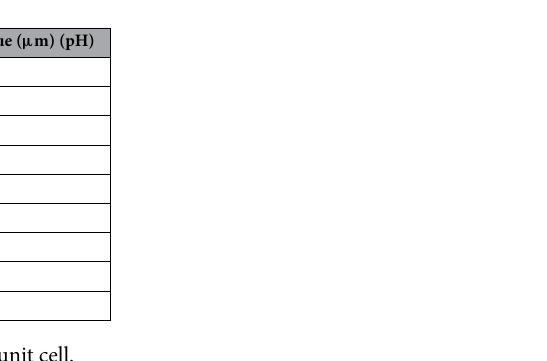
Figure 1. ( a ) Schematic depicting the terahertz transmission through the proposed MM configurations. The incident THz field is polarized parallel to the split gap i.e, along the y axis. ( b ) Magnified view of the unit cell of the MM comprising of a toroidal SRR and two asymmetric C shaped resonators made up of aluminium. The two C shaped resonators are placed symmetrically on both sides of the TSRR. The dimensions of the unit cell are periodicity ‘ P x ’ = 130 µ m , ‘ P y ’ = 80 µ m , width ‘ w’ = 4 µ m . Split gaps ‘ g’ and ‘ g 1 ’ = 3 µ m , ‘ g 2 ’ = 21 µ m . The length of mid SRR (TSRR) is ‘ L’ = 32 µ m and that of the other C shaped SRRs (CSRR) is ‘ L 1 ’ = ‘ L 2 ’ = 30 µ m . The distance of each CSRR from the mid TSRR is termed as ‘ d ’. ( c ) Transmission spectra showing multiband transparency effect for ‘ d ’= 10 µ m .